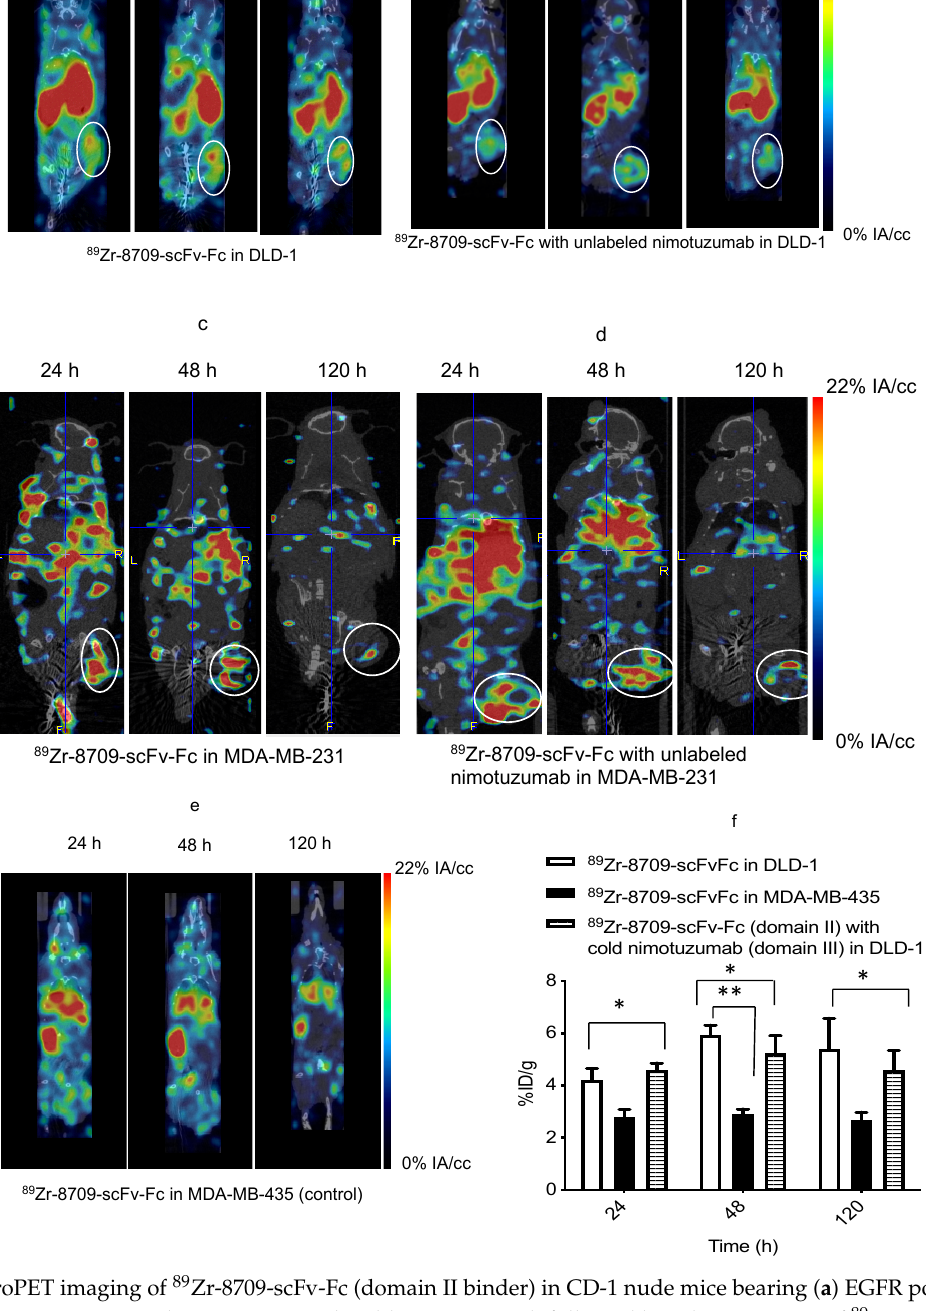
Figure 5. MicroPET imaging of 89 Zr-8709-scFv-Fc (domain II binder) in CD-1 nude mice bearing ( a ) EGFR positive DLD-1, ( b ) Pre-blocking DLD-1 tumor bearing mice with cold nimotuzumab followed by administration of 89 Zr-8709-scFv-Fc, ( c ) EGFR positive MDA-MB-231, ( d ) Pre-blocking MDA-MB-231 tumor bearing mice with cold nimotuzumab followed by administration of 89 Zr-8709-scFv-Fc, ( e ) control MDA-MB-435 xenografts at 24, 48, and 120 h p.i., and ( f ) Quantification of tumor uptake presented as %IA/g +/- SEM. Mice was initially pre-injected with 250 µg of unlabeled nimotuzumab to block domain III, and was followed by a tail vein injection of 89 Zr-8709-scFv-Fc (domain II specific). * indicates no statistical difference between 89 Zr-8709-scFv-Fc vs unlabeled nimotuzumab + 89 Zr-8709-scFv-Fc. ** indicates significant difference between EGFR positive DLD-1 and control MDA-MB-453 xenografts. Simultaneous targeting of domain III and domain II of EGFR was studied by dual